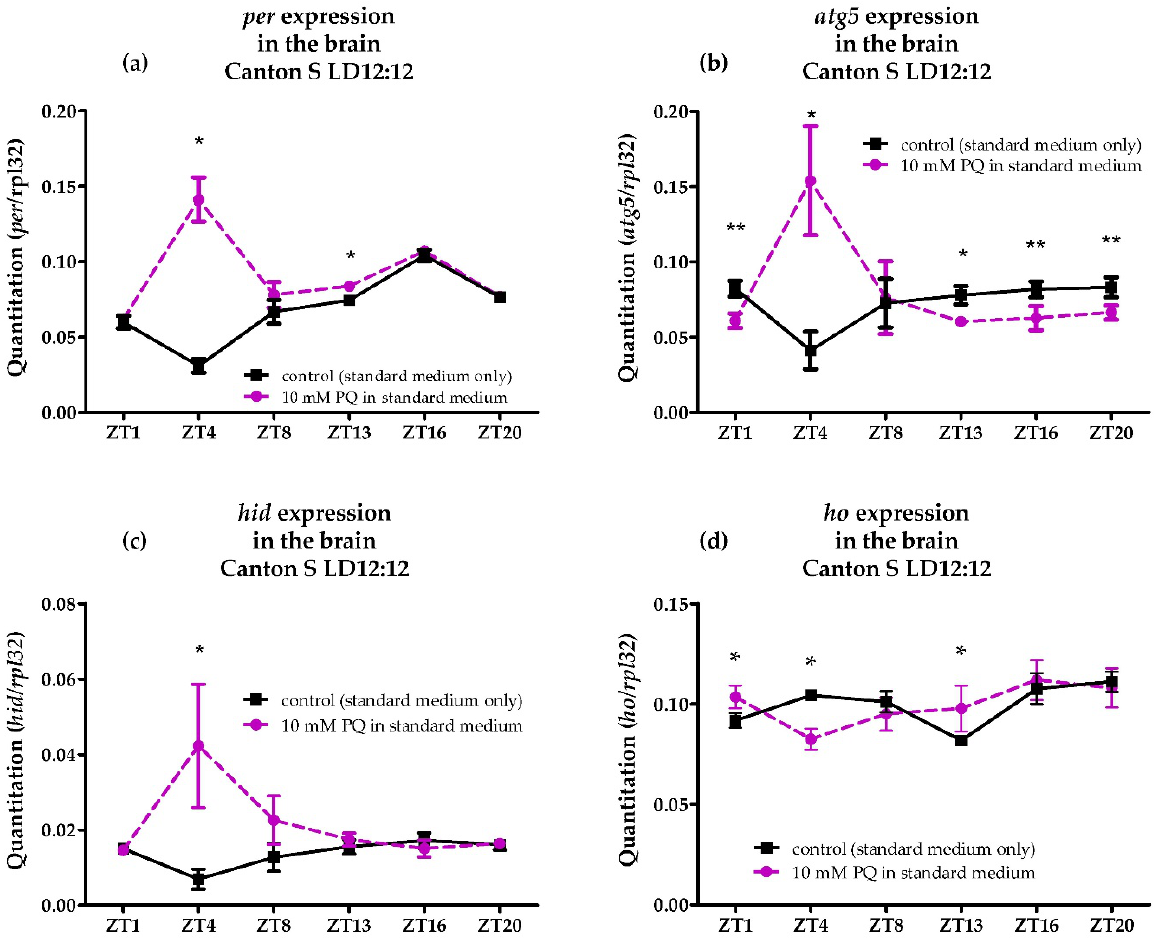
Figure 5. Effects of paraquat (PQ) exposure (for 24 h) on the mRNA level of period ( per ) ( a ), autophagy-related 5 ( atg5 ) ( b ), apoptosis activator head involution defect ( hid ) ( c ), and heme oxygenase ( ho ) ( d ) genes in the brain of adult males of Drosophila melanogaster . Data shown as means ± SD. Statistically significant differences between groups are indicated with asterisks (* p < 0.05 and ** p <